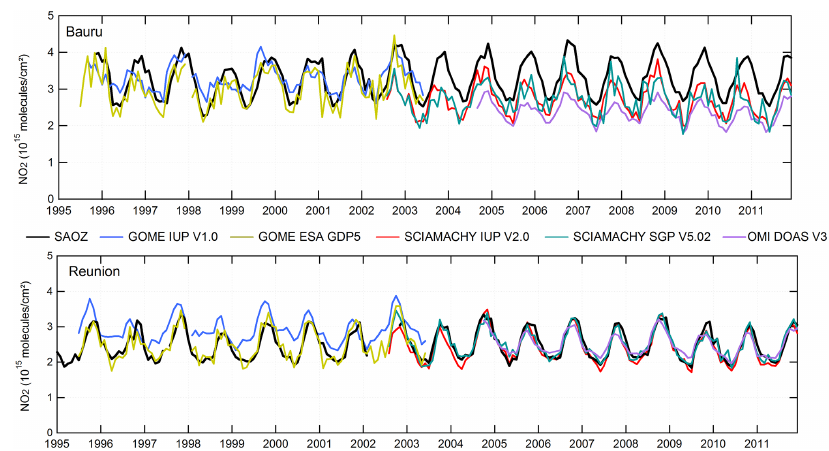
Figure 13. Satellite monthly mean NO 2 columns corrected to 90 ◦ AM over Bauru (top) and Reunion (bottom). GOME GDP5 (green), GOME IUP V1 (blue), SCIAMACHY IUP V2 (red), SCIAMACHY SGP5 (dark green), OMI DOAS V3 (purple). Time series of SAOZ at sunrise have been added in black.